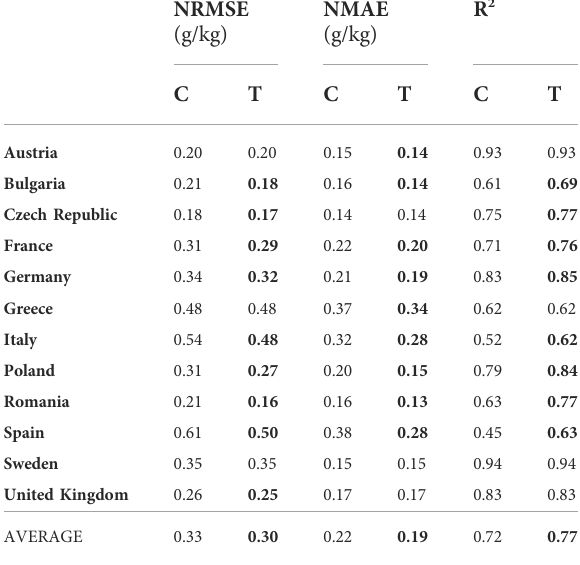
TABLE 3 Comparing classical(C), and transfer learning (T) approach in a Grassland-to-Cropland setting: normalized RMSE and MAE (lower is better), and R 2 (higher is better), indicate the bene fi ts of the proposed TL approach.